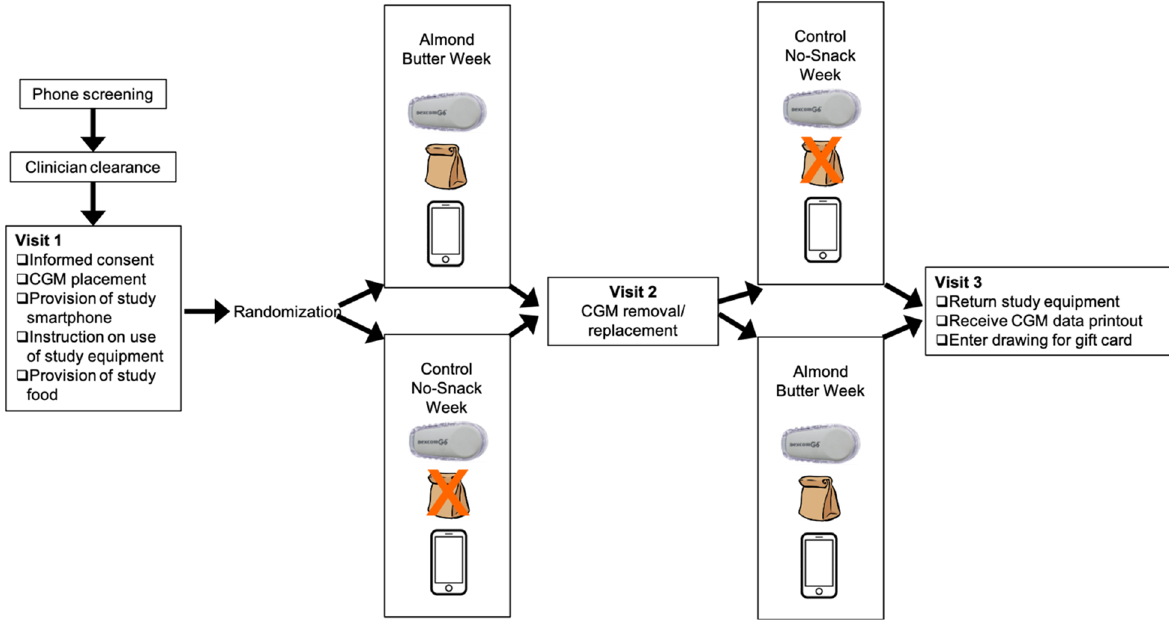
Figure 1. Study Design; Each period was 1 week long with no breaks between periods.